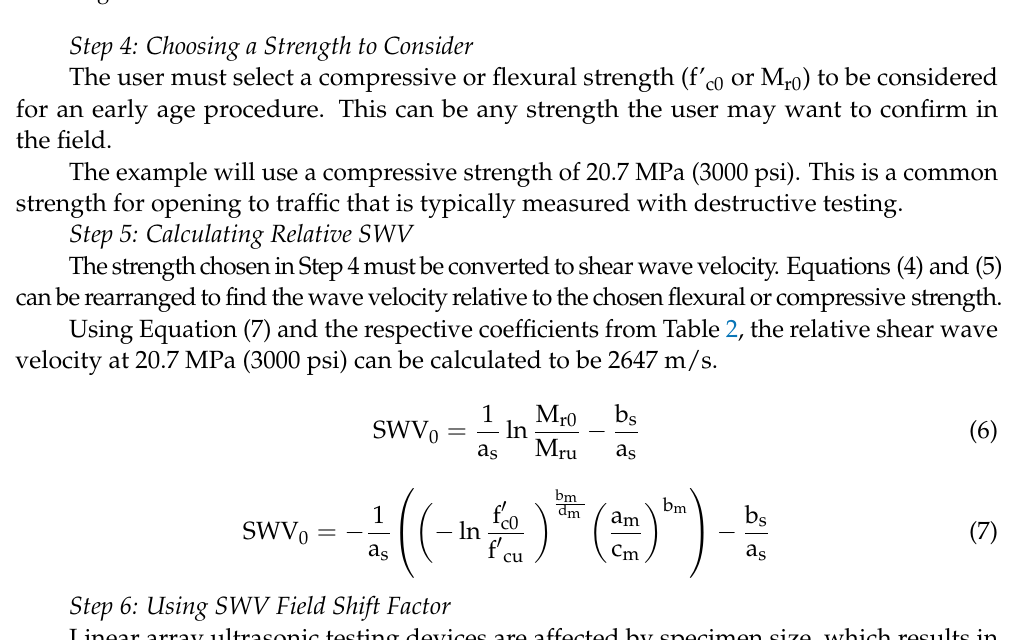
Figure 2. Test section SWV– strength relationships for ( a ) compressive strength and ( b ) flexural strength.